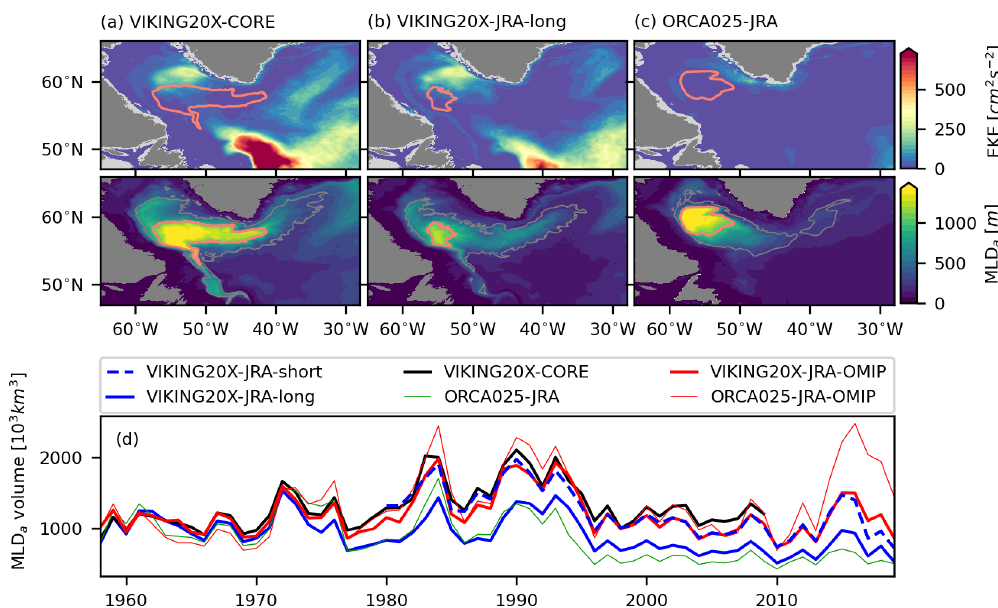
Figure 9. Spatial pattern and temporal variability of mixed layer depth (MLD) (i.e. the depth that exceeds density at 10m depth by 0.01kgm − 3 ) in the subpolar North Atlantic: long-term (1980–2009) mean eddy kinetic energy (EKE) at 112m depth and annual maxi- mum MLD (MLD a ) in (a) VIKING20X-CORE, (b) VIKING20X-JRA-long and (c) ORCA025-JRA, light red contours highlight long-term mean MLD a > 1000m and grey contours the long-term maximum MLD a > 1000m; (d) interannual variability of spatially integrated MLD a , resulting in a volume.